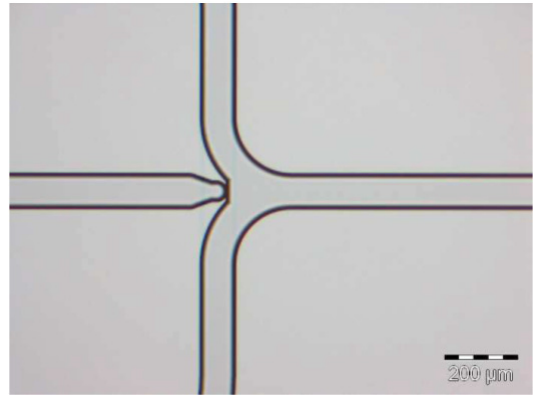
Figure 5. Focused-Flow Droplet Generator chip [18].